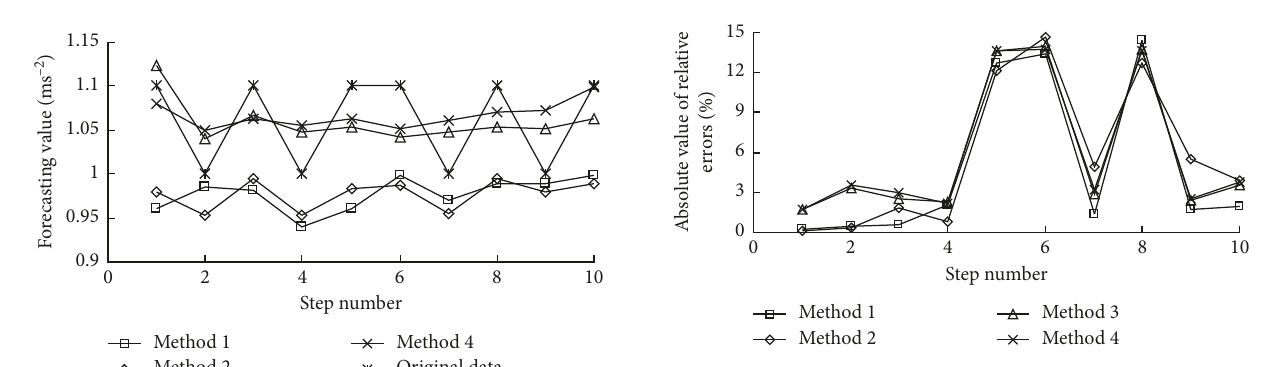
Figure 6: Absolute value of the relative errors from the prediction results from subseries X 1 . 3 .